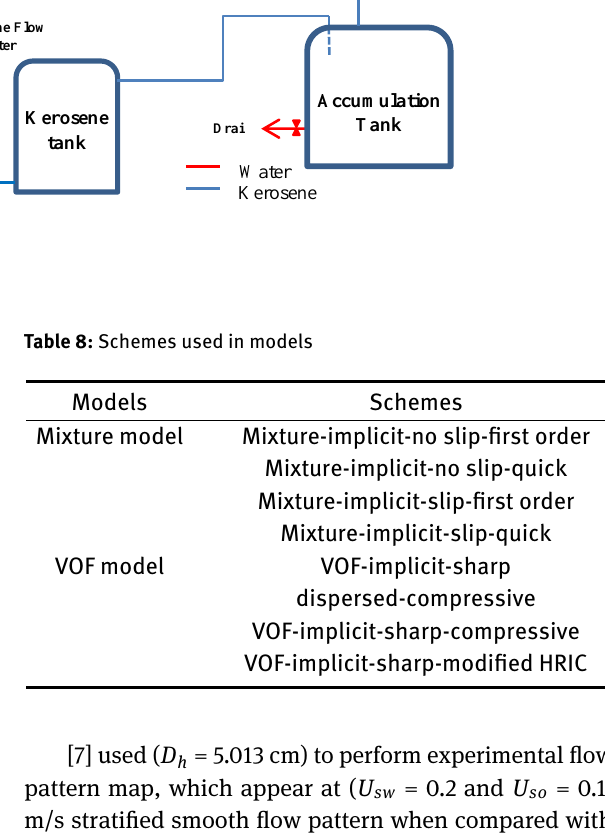
Fig. 3: Adjustment for circular to rectangular cross section